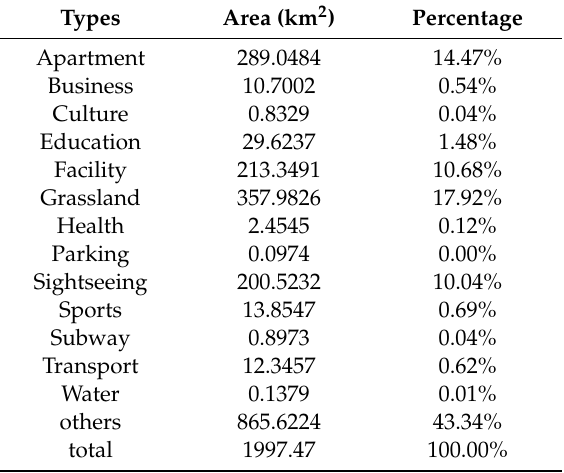
Table 3. Statistics table of land-use types.